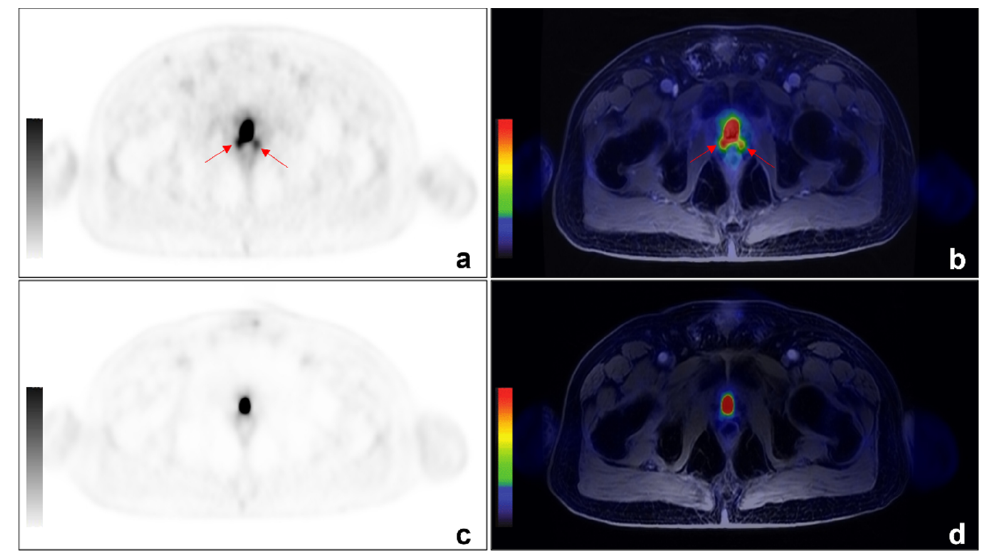
Figure 2. An example of discordant findings between 68 Ga-PSMA and 68 -Ga-DOTA-RM2 PET/MRI in detecting PCa local recurrence. A 64 year-old patient previously treated with radical prostatectomy for PCa (Gleason 4 + 3) experienced biochemical recurrence of PCa (PSA = 2.5 ng/mL). 68 Ga-PSMA PET/MRI showed radiotracer uptake (red arrows) in correspondence of the right and left posterior sides of the prostatic lodge. (( a ): axial 68 Ga-PSMA PET; ( b ): axial 68 Ga-PSMA PET/MRI). No pathological uptake was detected on 68 Ga-DOTA-RM2 PET/MR images ( c ): axial 68 Ga-DOTA-RM2 PET; ( d ): axial 68 Ga-DOTA-RM2 PET/MRI).